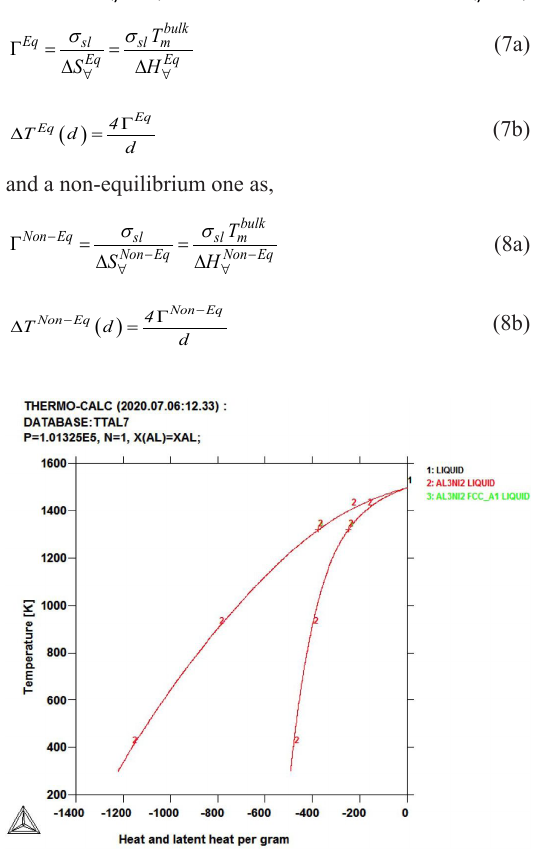
Figure 1. Equilibrium and non-equilibrium latent heat and latent heat per gram as a function of temperature for